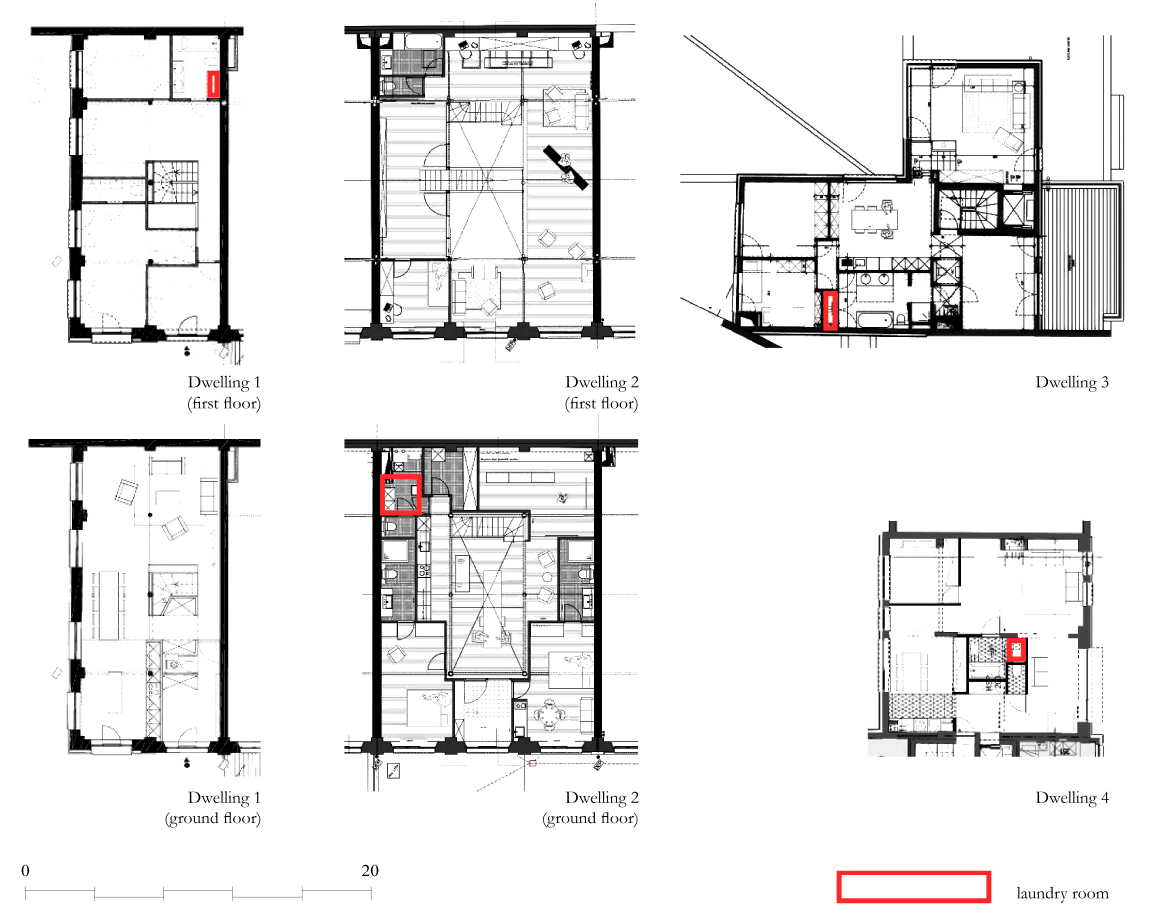
Figure 10. Laundry rooms (drawings by the authors,